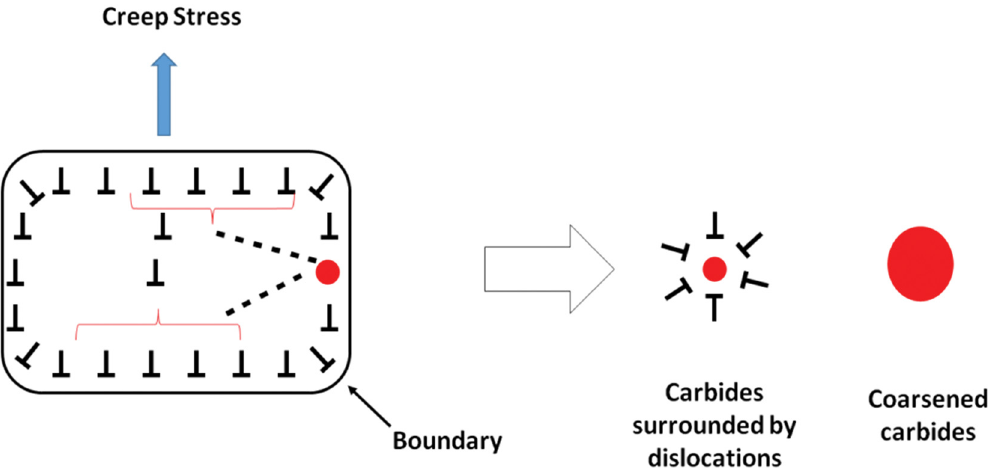
Figure 3: Pipe di ff usion leading to precipitate coarsening ( assuming the spherical shape of precipitates )